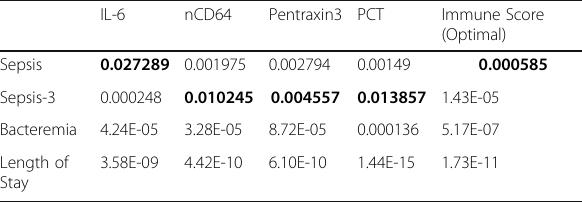
Table 2 (abstract P42). See text for description